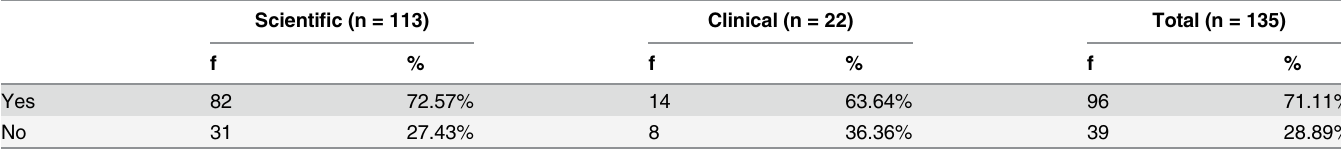
Table 8. Responses to “ Have you ever shared data with another researcher, either informally or through a formal agreement, such as a Material Transfer Agreement or Data Sharing Agreement? ”